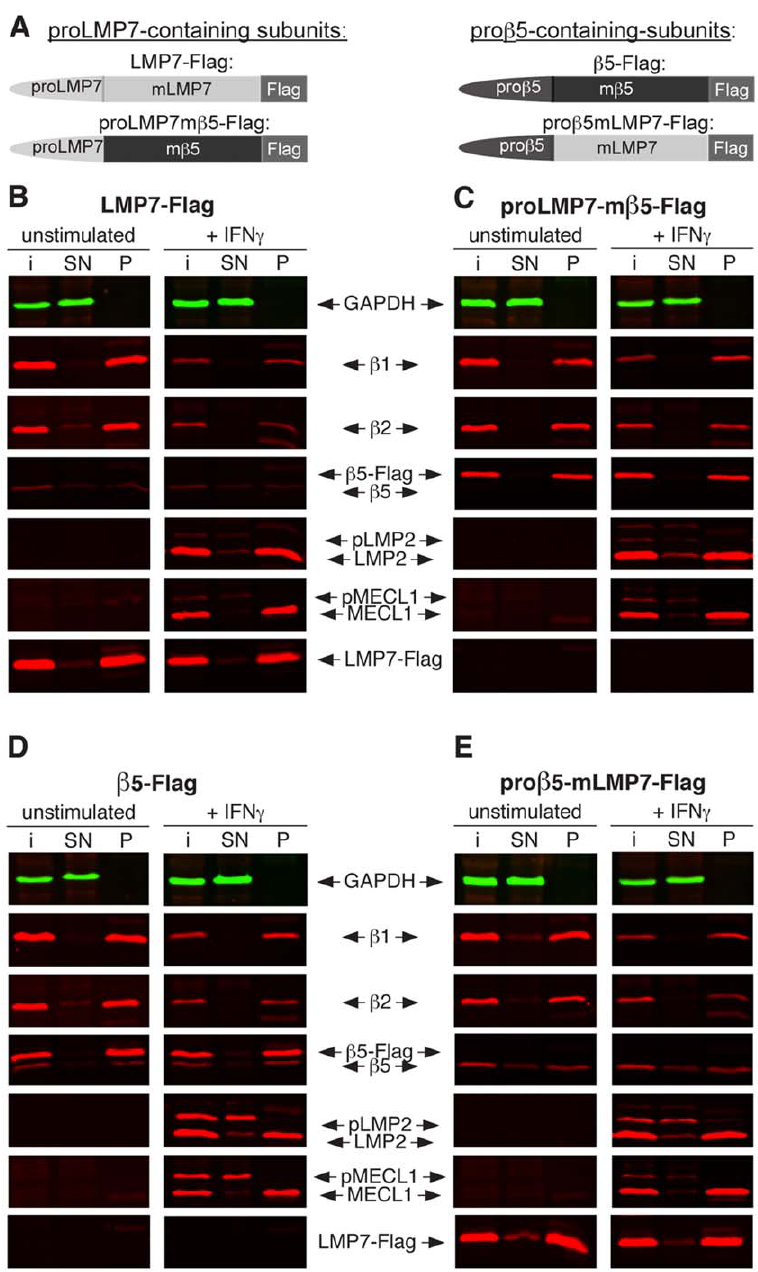
Figure 1. Co-immunoprecipitation analysis using pro b 5- and LMP7-containing proteasome subunits over-expressed in lmp7 2 / 2 Mefs. Flag-tagged full-length LMP7 (LMP7-Flag), proLMP7 fused to mature b 5 (proLMP7m b 5-Flag), full-length b 5 ( b 5-Flag) and pro b 5 fused to mature LMP7 (pro b 5mLMP7-Flag) were over-expressed in lmp7 2 / 2 Mefs by retroviral transduction (A). The lmp7 2 / 2 Mef lines expressing the four different constructs were either left unstimulated or cultured in the presence of 50 U/ml IFN c for 4 days. Following cell lysis, the Flag-tagged subunits were precipitated with anti-Flag-M2 H agarose. Co-precipitation of the catalytic proteasome subunits b 1, b 2, LMP2 and MECL-1 with the proLMP7-containing subunits LMP7-Flag (B) and proLMP7m b 5-Flag (C) or the pro b 5-containing subunits b 5-Flag (D) and pro b 5mLMP7-Flag (E), was analysed by Two-colour fluorescent immunoblot analysis. The abundance of each subunit was determined in the input material (i), the supernatant of the immunoprecipitation (SN) and the precipitate (P) for both conditions